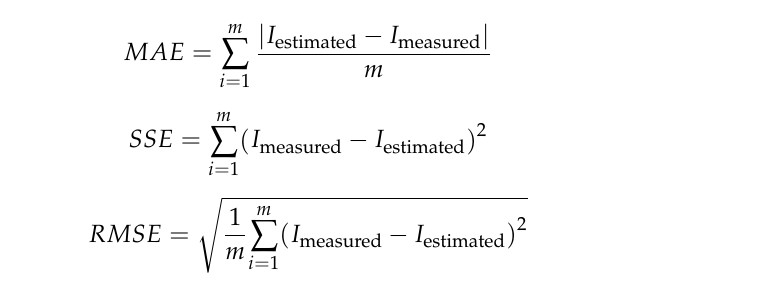
Table 7. Statistical result for single diode model (RTC France Company).